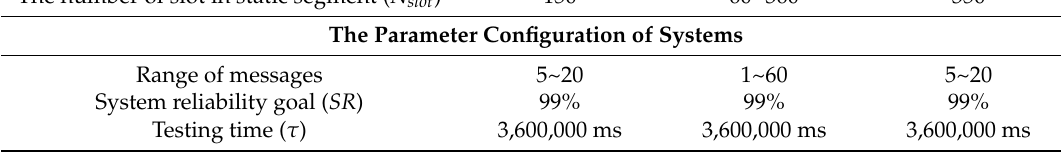
Table 3. Comparison of running time and slot utilization with Li’s method.